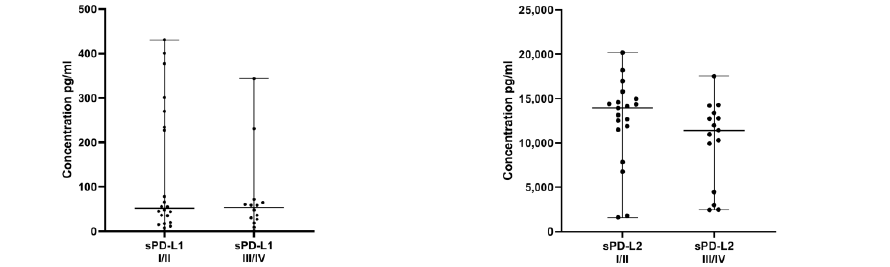
Figure 8. Levels of sPD-L1 and sPD-L2 in the plasma and peritoneal fluid in early (I/II) and late (III/IV) ASRM stages of endometriosis ( A – D ) pg/mL. Figure 9. Levels of sPD-L1 ( A ) pg/mL and sPD-L2 ( B ) pg/mL in the plasma of patients with endo- metriosis and control group. The median values with the following sign indicate statistically sig- nificant differences: *** p <